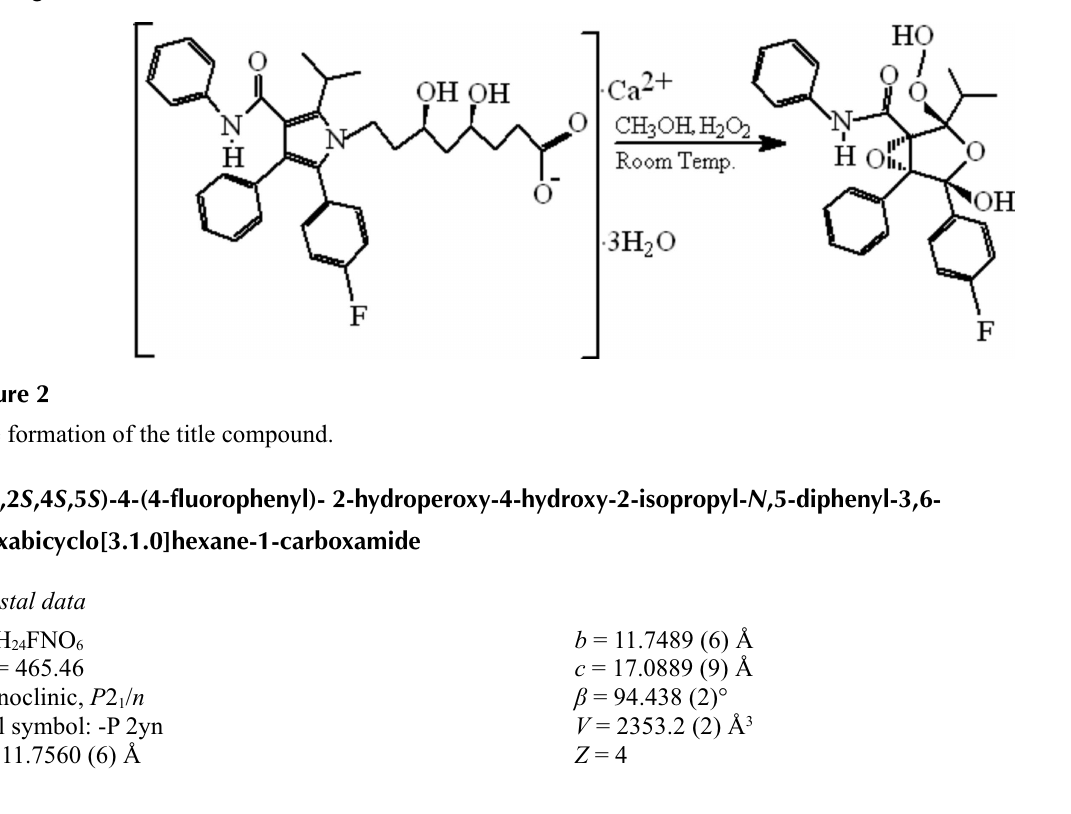
Figure 1 ORTEP drawing of the title compound, with the atom numbering scheme. The thermal ellipsoids are drawn at the 30% probability level. H-atoms are shown by small circles of arbitrary radii. The dashed lines shows intramolecular H- bonding.